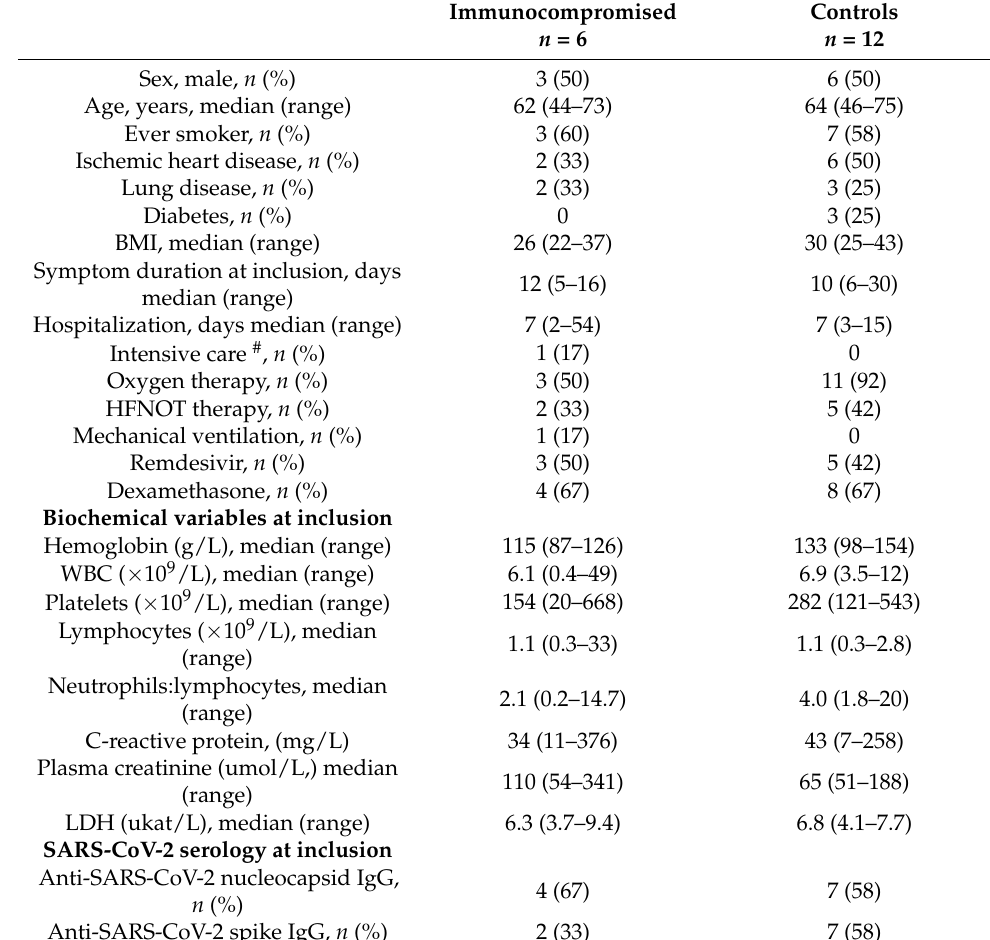
Table 1. Clinical characteristics of the study cohort, biochemical variables, and SARS-CoV-2 serology at